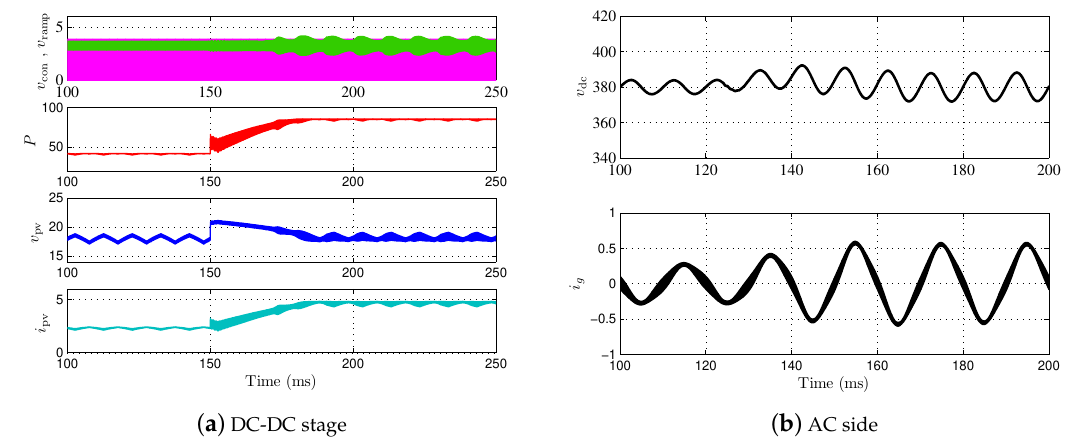
Figure 9. The simulated PV system response to a change at t = 150 ms in the irradiance level from 500 W/m 2 ( P max 42 W) to 1000 W/m 2 ( P max 85 W). V M = 4 V. Θ = 25 ◦ C. ≈ ≈